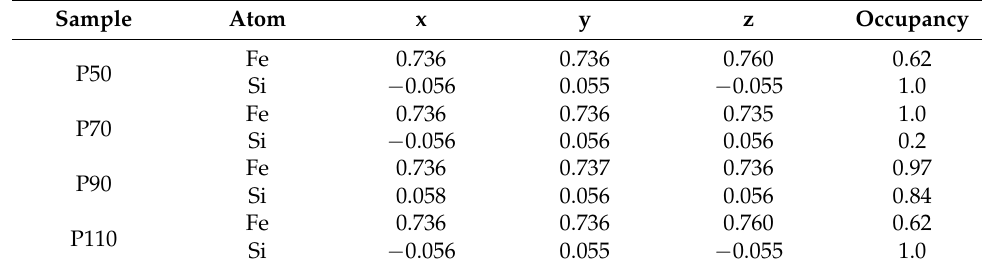
Table 3. Atomic positions and occupancy of Fe and Si atoms in the ε -FeSi crystal lattice.